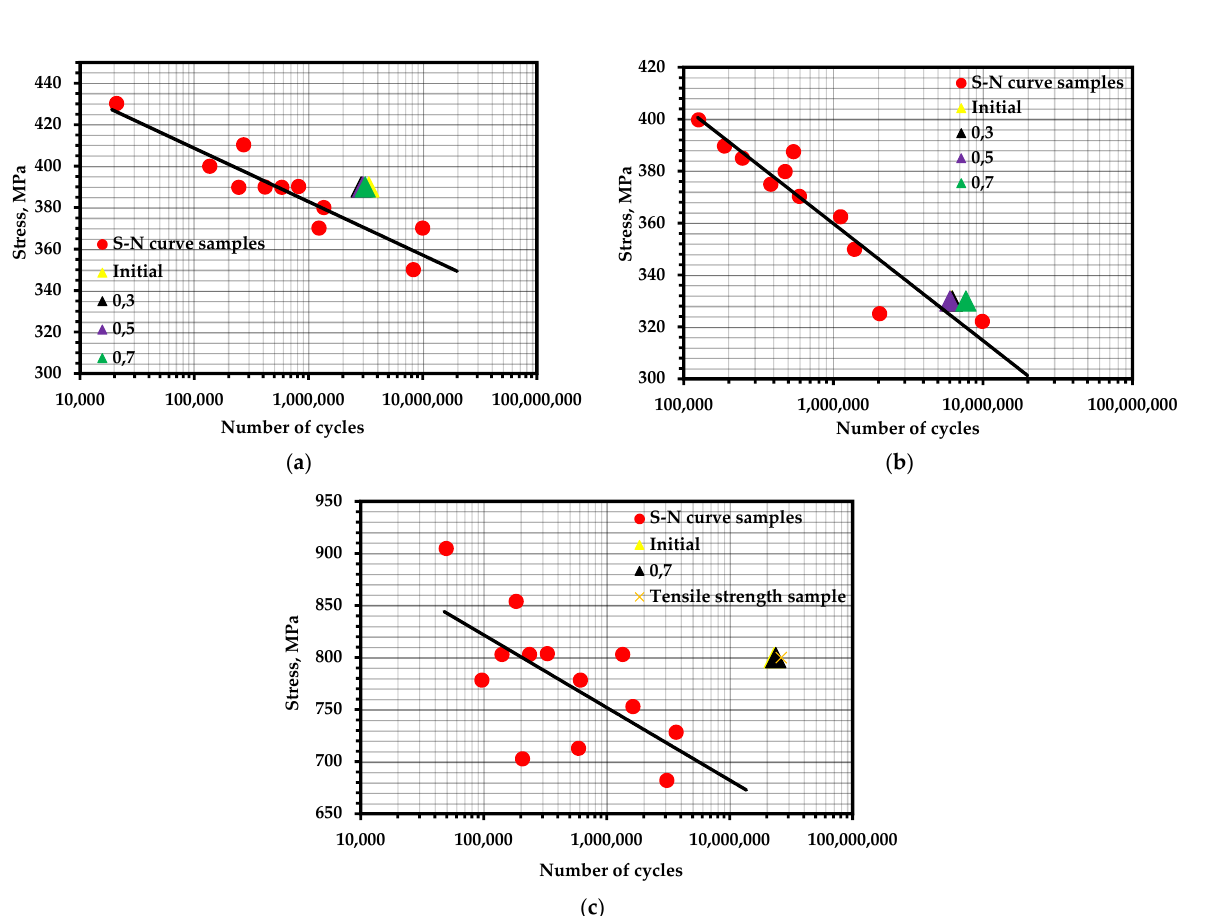
Figure 10. S–N curves for experimental materials with marked points of calculated fatigue life: ( a ) steel 20 with pre-cycling at 390 MPa; ( b ) steel 20 with pre-cycling at 330 MPa; ( c ) 15X2GMF steel with pre-cycling at 800 MPa.